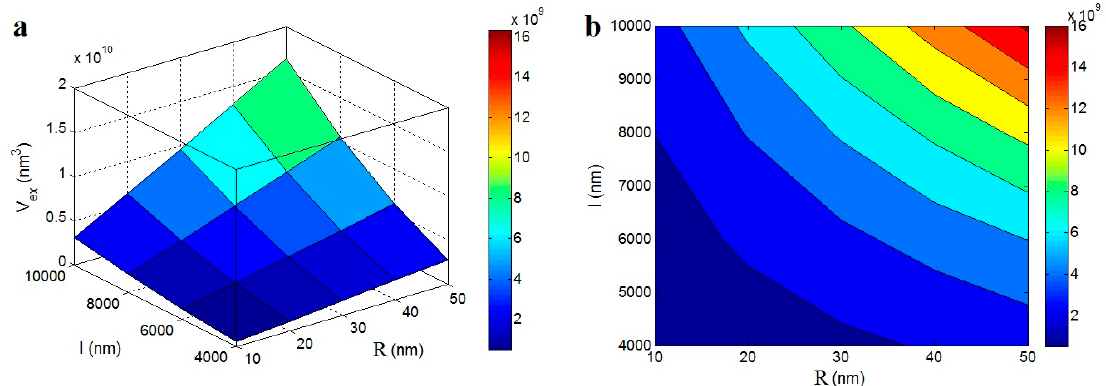
Figure 3. The roles of “ R ” and “ l ” parameters in the excluded volume according to Equation (3): ( a ) 3D and ( b ) contour illustrations.